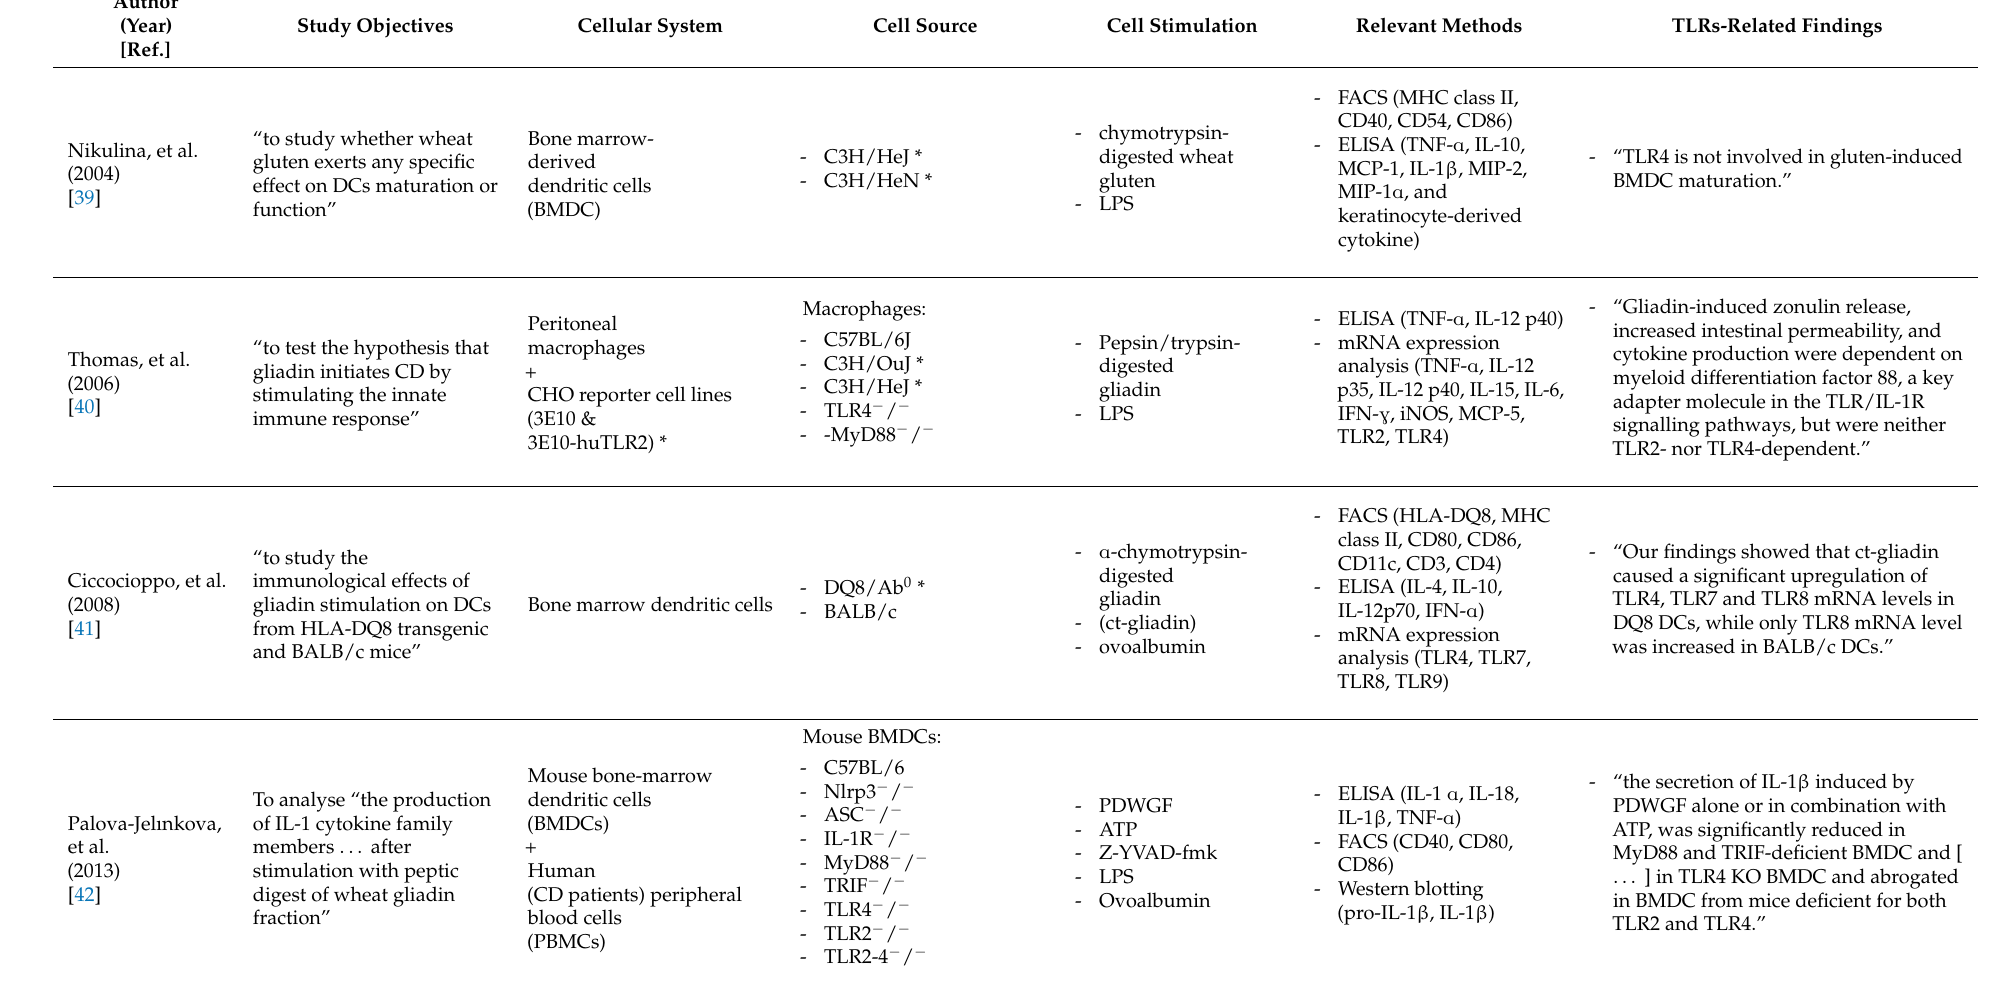
Table 2. Ex vivo/in vitro cellular experiments investigating TLRs in the response of innate immune cells to gluten